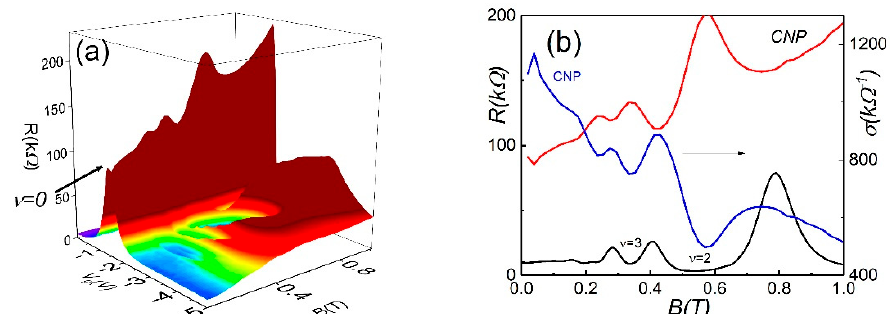
Figure 3. (Color online) ( a ) Color map of R xx ( N s , B ) versus N s and B at T = 4.2 K for a macroscopic device. ( b ) The red trace represents the longitudinal R xx resistance as a function the magnetic field ( B ) at the CNP. The blue trace represents the conductivity σ xx as a function the magnetic field ( B ) at the CNP. The black trace represents R xx in the quantum Hall effect regime for 2D Dirac holes as a function the magnetic field ( B ) at V g = − 2.5 V .